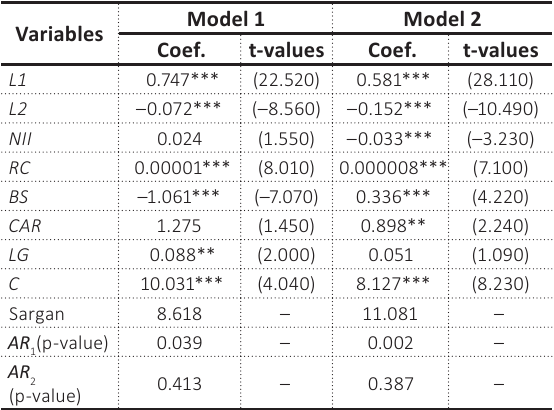
Table 4. Two-step dynamic panel